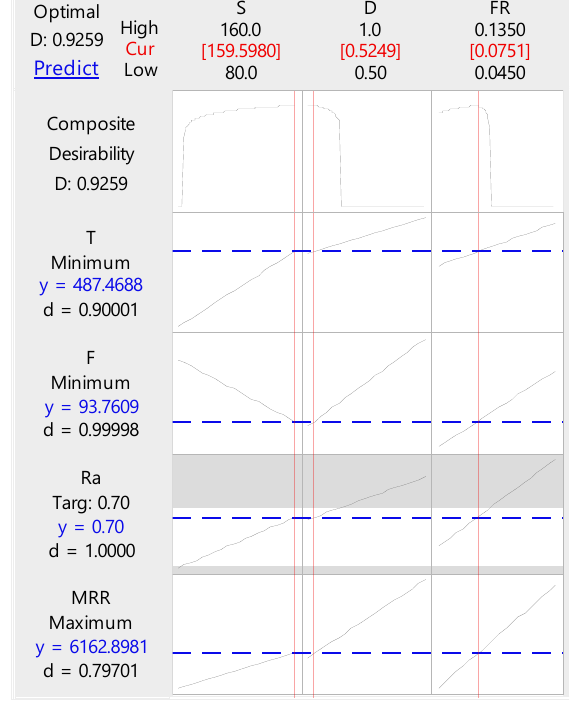
Figure 16. Optimization plot for responses using wiper cutting edge.